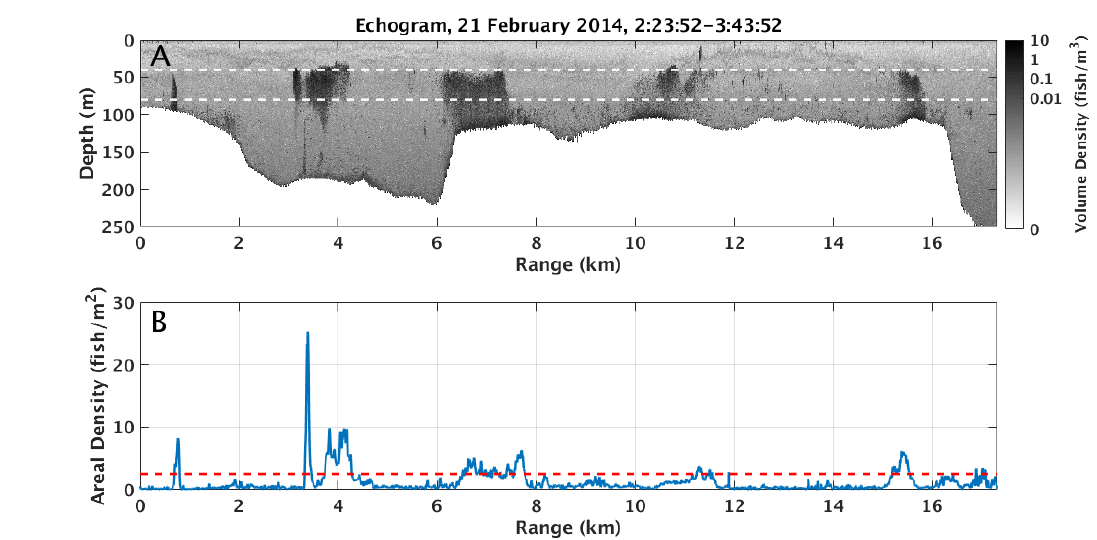
Figure A3. Synoptic echosounder measurements of vertical position ( A ) and areal density ( B ) for Ålesund herring collected during the 2014 OAWRS experiment are consistent with fish shoal parameters inverted in Figure 4. White dotted lines in ( A ) designate the inverted vertical position of the occluding shoal (mean shoal depth z 0 = 60 m with vertical thickness H = 40 m), while the red dotted line in ( B ) designates the inverted areal density (2.5 fish/m 2 ). While the echosounder measurements shown here do not directly sample the occluding shoal analyzed in Figure 4, they were recorded between 1 and 2.5 h before the OAWRS measurements of the occluding shoal and less than 10 km from its